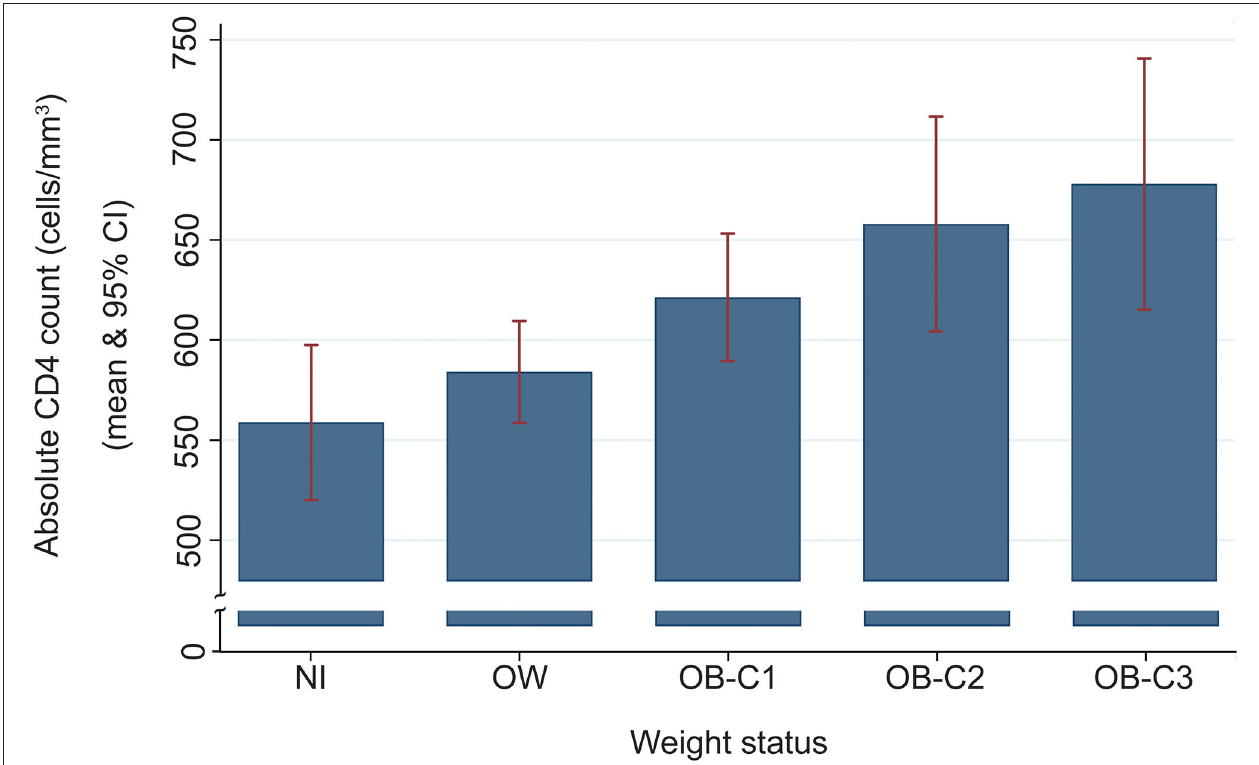
FIGURE 2 | A histogram depicting an increase of absolute CD4 lymphocytes with an increase of body weight. The regression with CD4 + T cell counts (square root transformed) was b = 0.48 (robust HC3 se = 0.16), p = 0.004. NW, normal weight; OW, overweight; OB-C1, obesity-category 1; OB-C2, obesity-category 2; and OB-C3, obesity category 3.